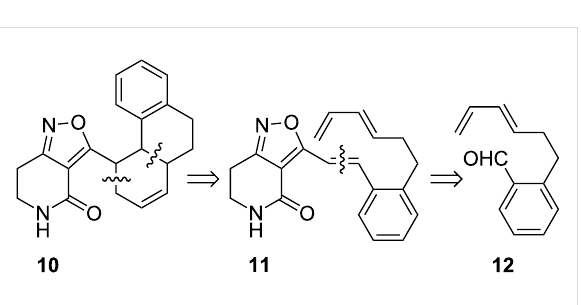
Scheme 2: Retrosynthetic analysis of a model 3-decalinyl-4,5,6,7- tetrahydroisoxazolopyridone 10